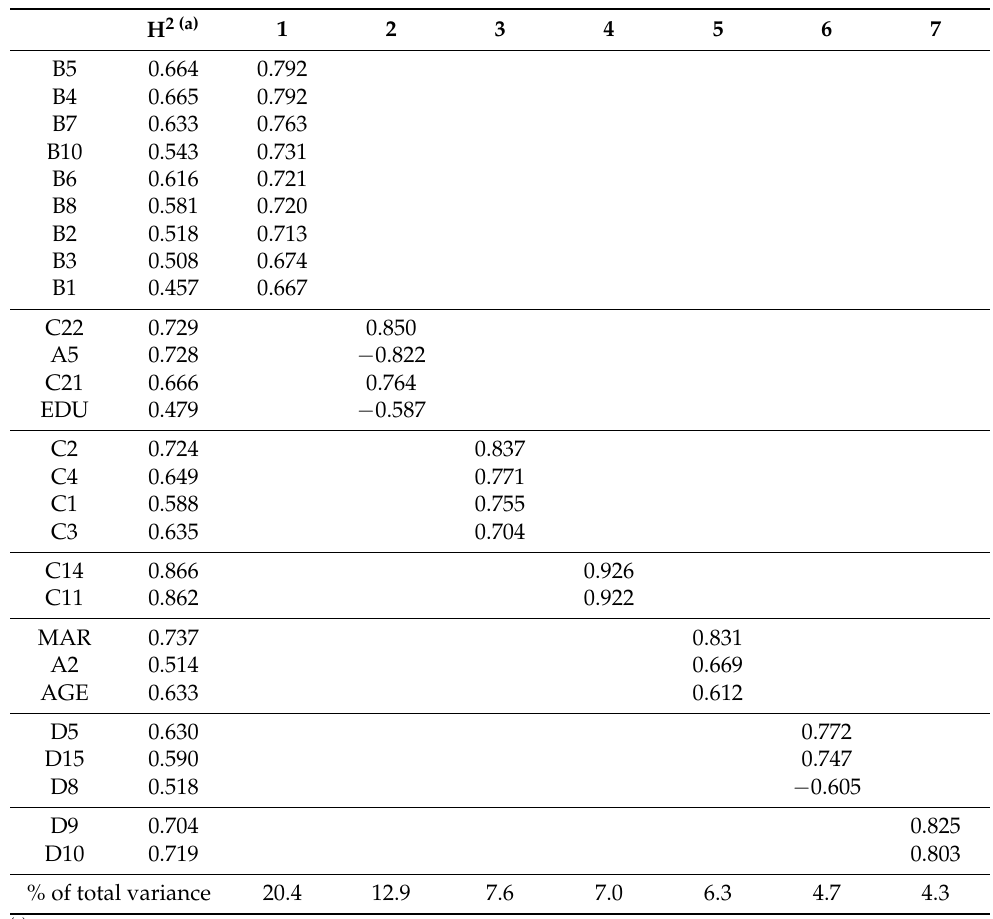
Table 3. Determinants of social isolation feeling in Greece during the